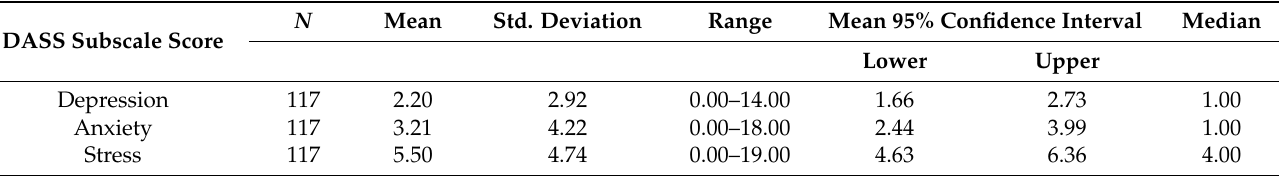
Table 3. DASS Descriptive statistics.